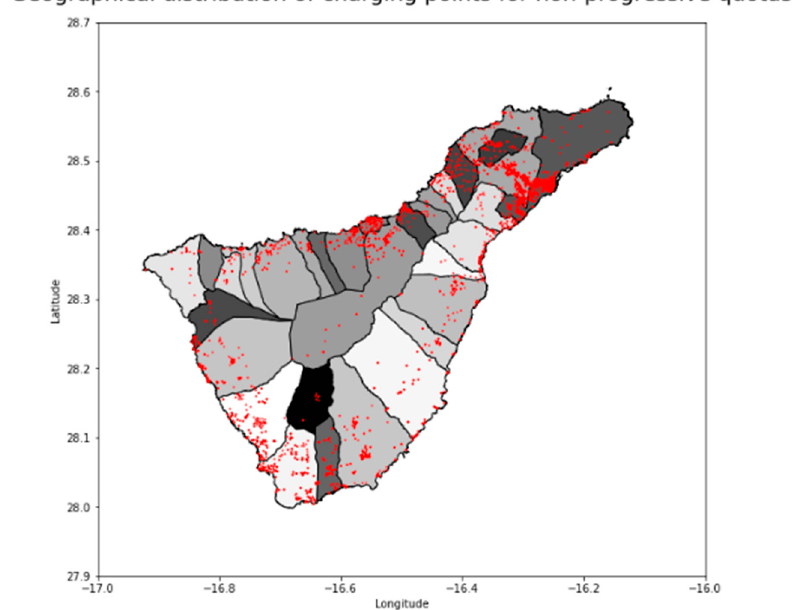
Figure 25. Distribution of charging points in Tenerife in 2028 for the non-progressive case.